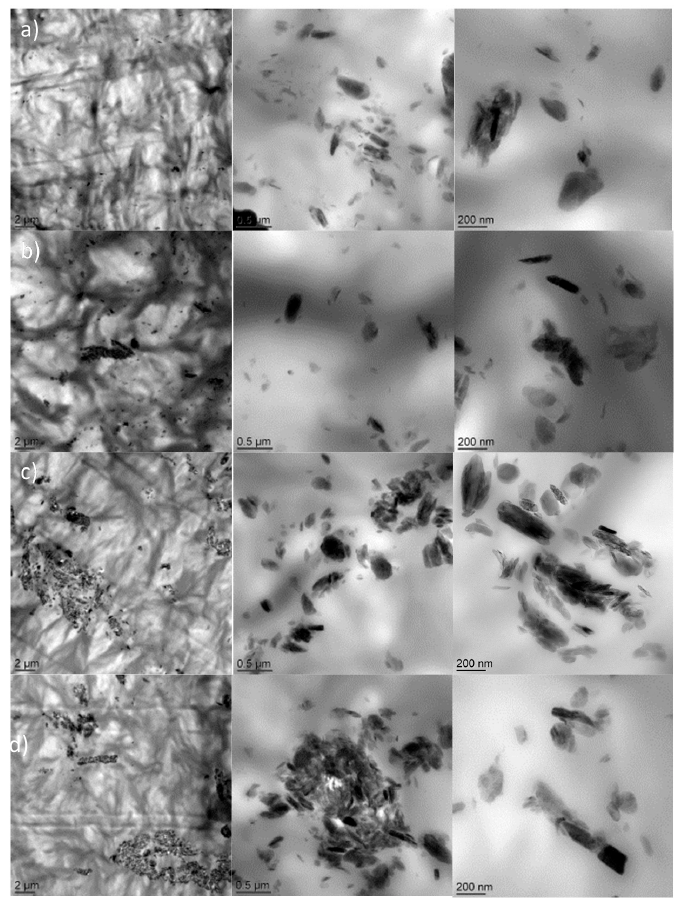
Figure 1. TEM micrographs of: ( a ) PCL + 1% LDH-EHT; ( b ) PCL + 3% LDH-EHT; ( c ) PCL + 5% LDH-EHT; and ( d ) PCL + 7% LDH-EHT.